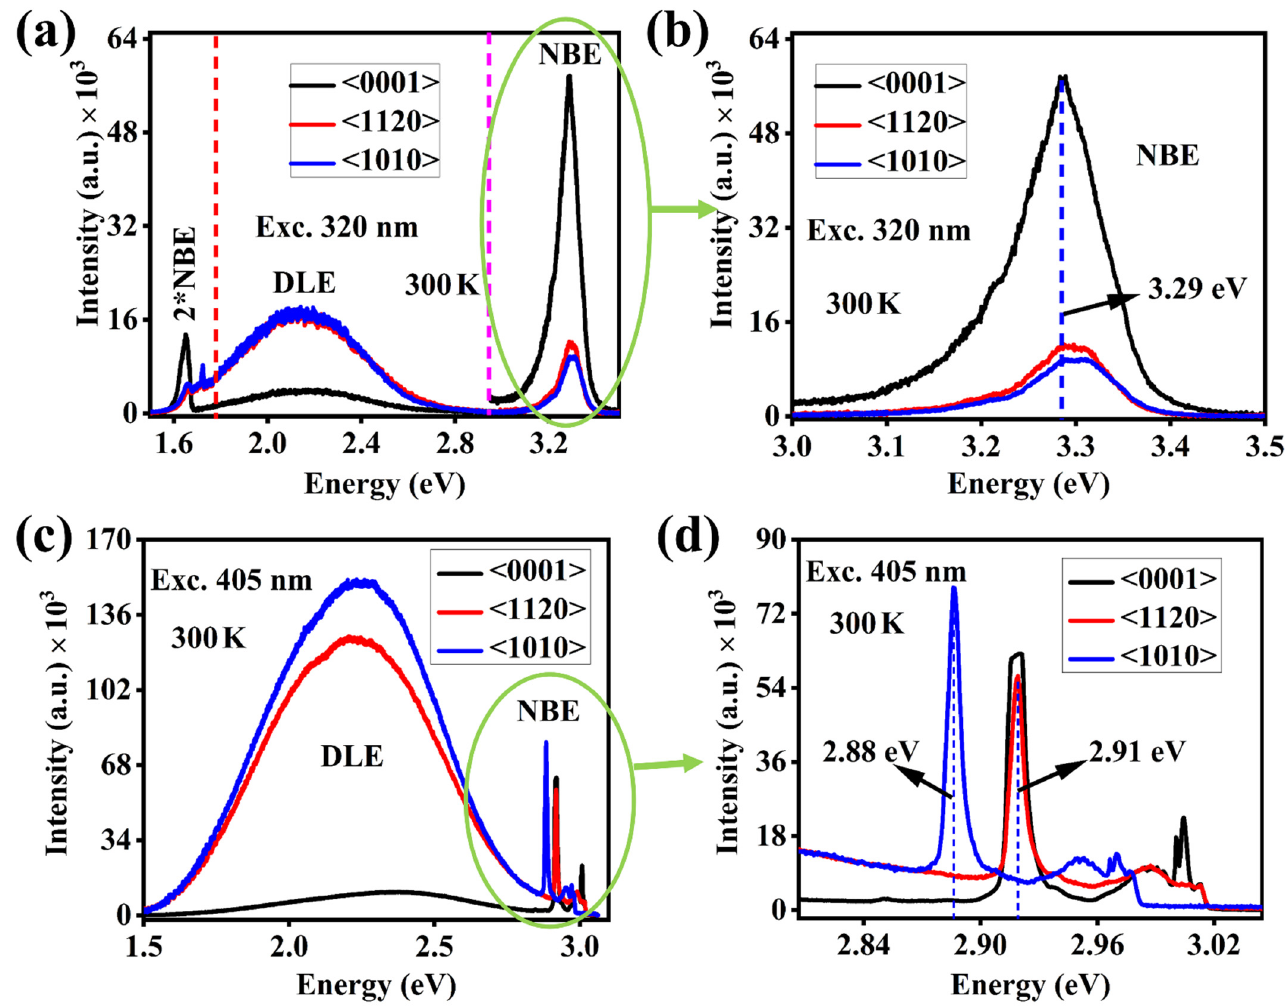
Figure 5. Room-temperature full scan PL spectra of ZnO single crystal with three different orientations ( a , b ) measured with 320 nm excitation laser, ( c , d ) measured using 405 nm excitation laser. Here NBE and DLE represents the near-band-edge and deep level emission, respectively.